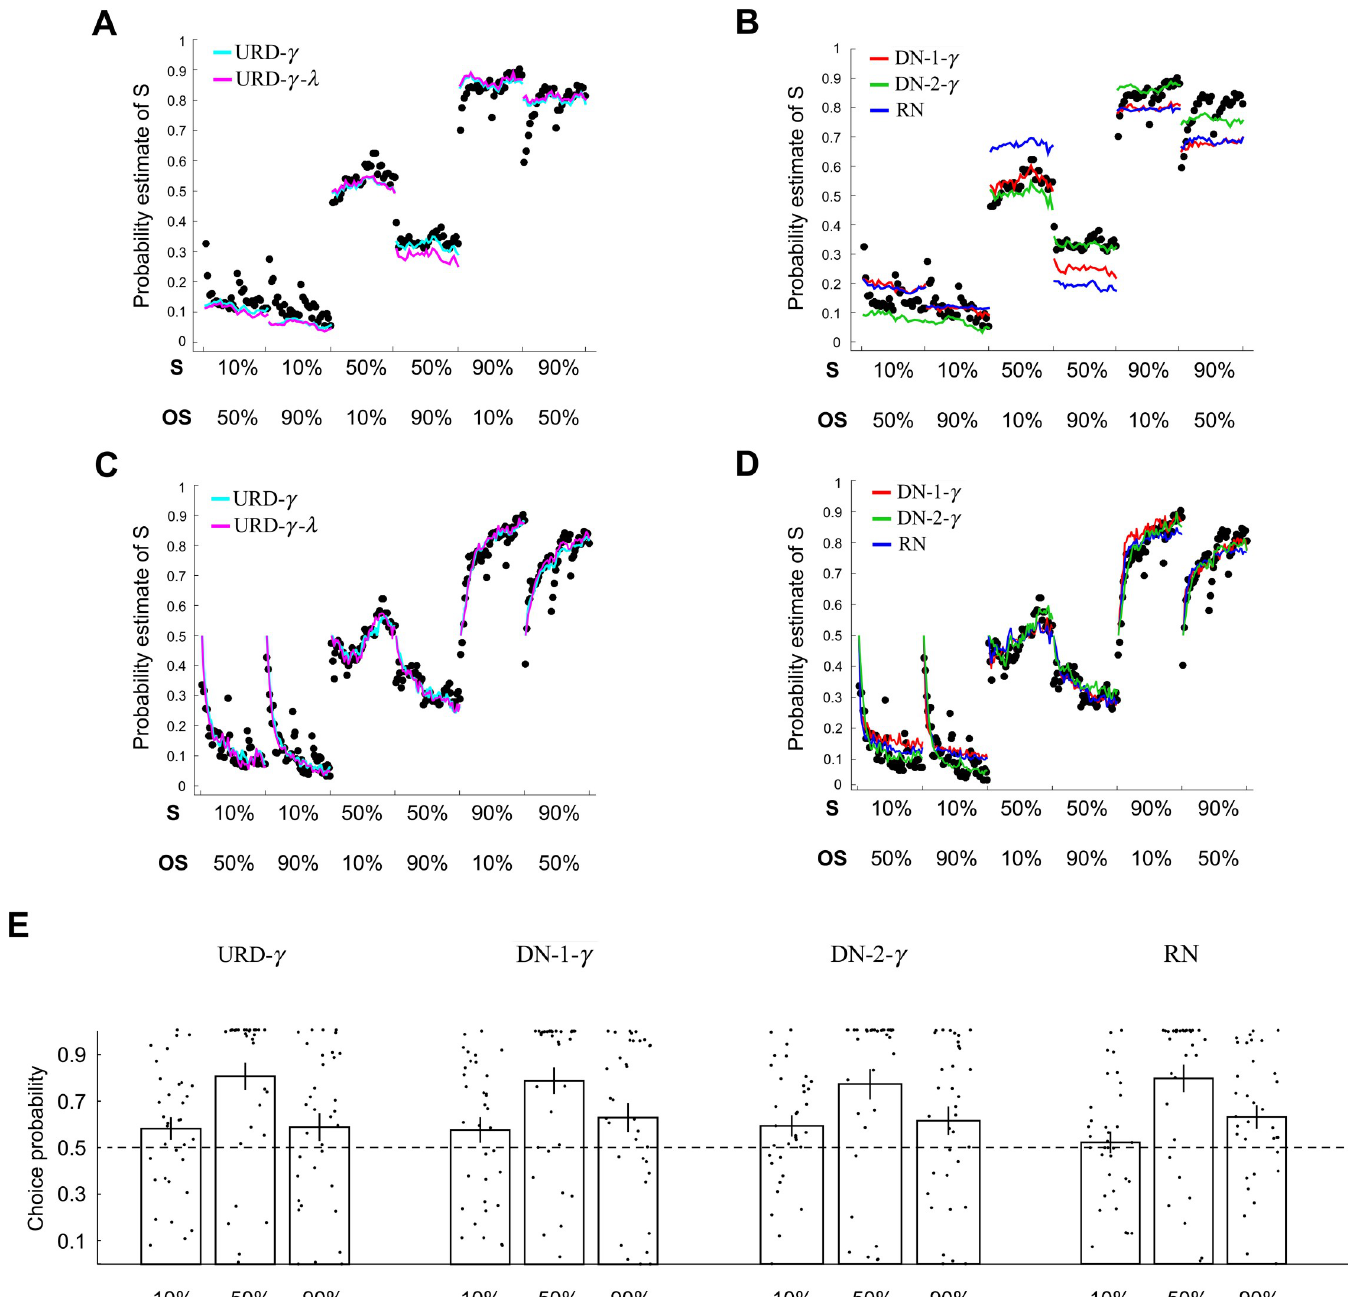
Fig 8. Model fitting results: Individual data. (A–B) Results from fitting the models at the individual-subject level. The mean model fits (averaged across subjects) are plotted along with subjects’ average probability estimate. (A) Results from URD models (URD- γ ,URD- γ - λ ). (B) Results from DN models (DN-1- γ ,DN-2- γ ) and RN model (RN). (C–D) Results from fitting the models implemented in the Rescorla–Wagner reinforcement-learning model framework. Models were fit at the individual-subject level. (C) Results from URD models (URD- γ ,URD- γ - λ ). (D) Results from DN models (DN-1- γ ,DN-2- γ ) and RN model (RN). (E) Model simulations on choice probability. Here, we show simulations from four of the models mentioned above. We plot choice probability based on simulated choice data according to the Rescorla– Wagner model parameter estimates from each subject. These results should be compared with subjects’ actual choice probability shown in Fig 3A. Conventions are the same as in Fig 3A. Data underlying these graphs can be found in https://osf.io/48j7m. DN, divisive normalization; OS, the other stimulus present in the same context as the stimulus of interest; RN, range normalization; S, stimulus of interest; URD, uncertainty and reference dependent.